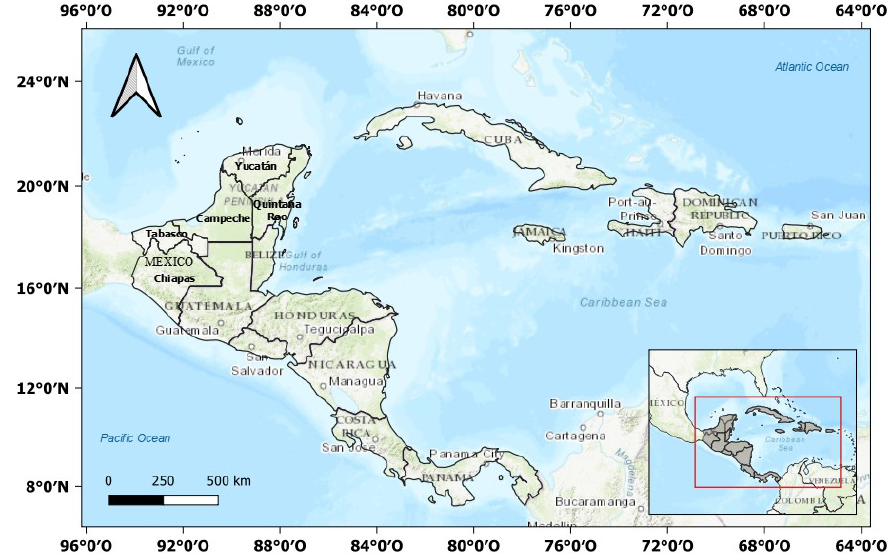
Figure 1. Study region (Southeast Mexico, Central America, and the Caribbean).